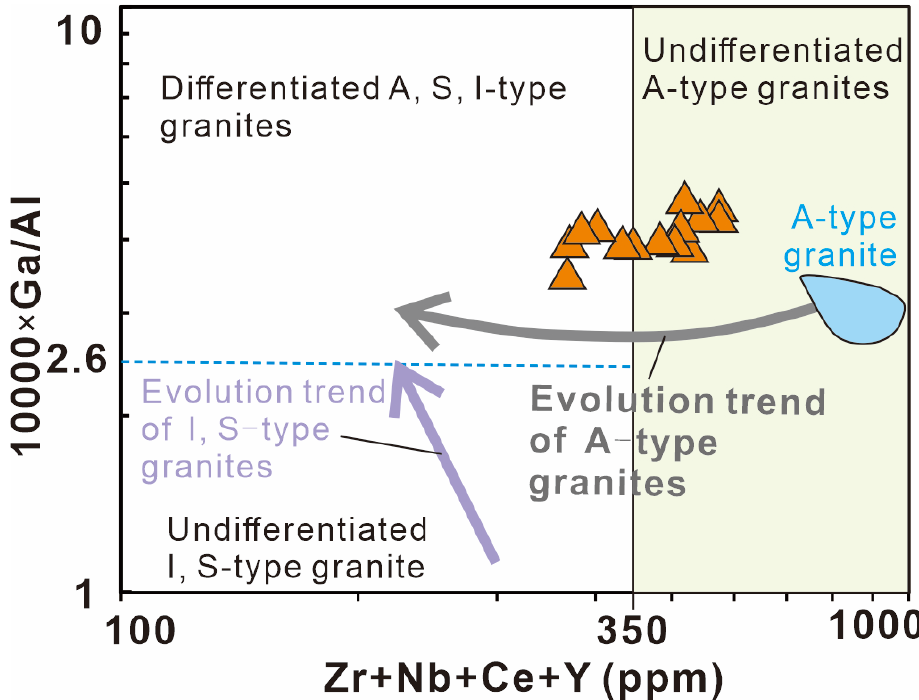
Figure 10. 10,000 × Ga/Al vs. (Zr + Nb + Ce + Y) diagram of the samples plot from the Duhongshan granites [71].